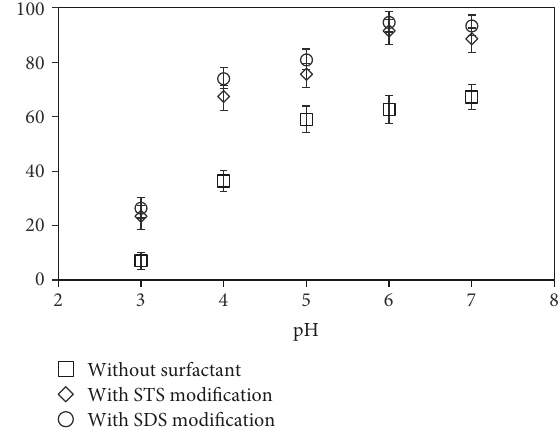
Figure 11: In fl uence of pH on removal of Cd 2+ using di ff erent Al O adsorbents (without surfactant, with STS modi fi cation, and 2 3 with SDS modi fi cation) at 1 mM NaCl. Error bars show standard deviations of three replicates.